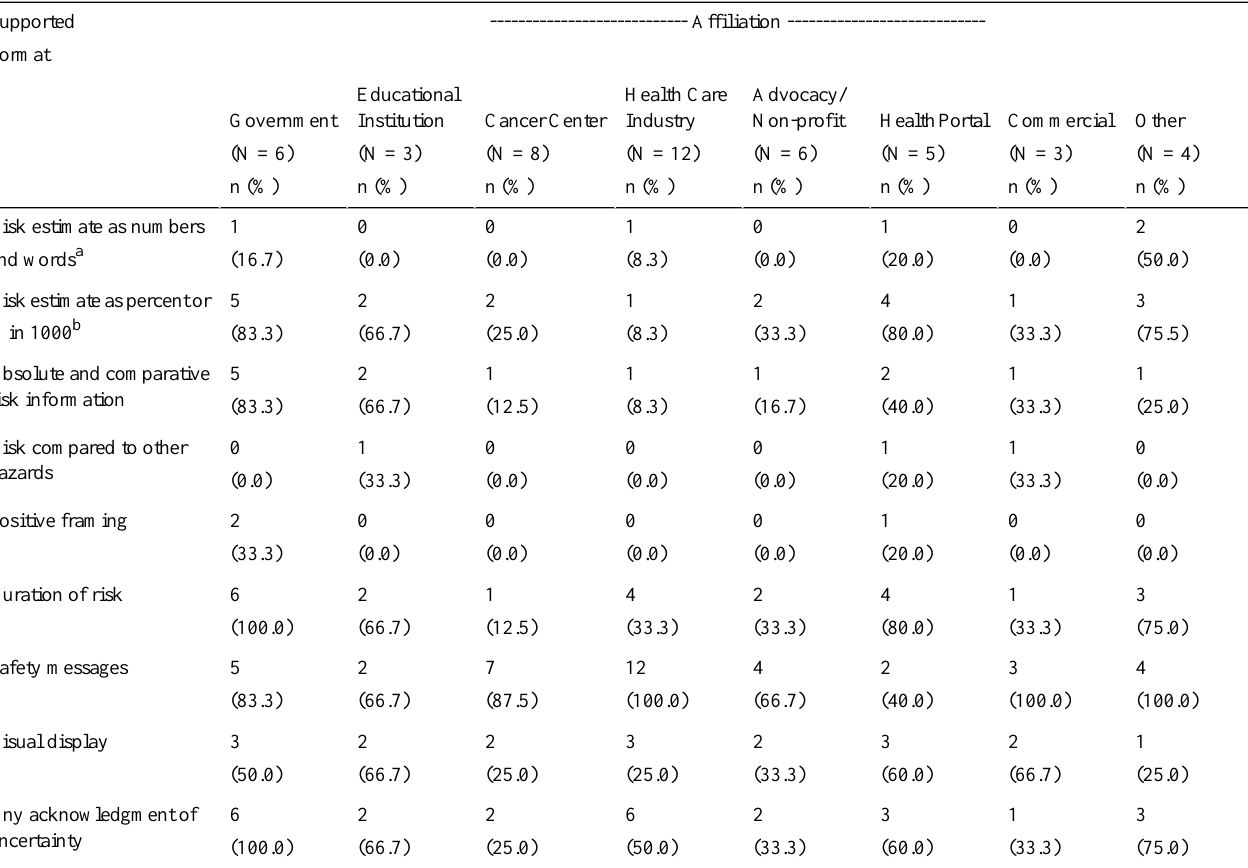
Table 6. Website affiliation-based variations in the use of risk communication formats that facilitate comprehension and reduce bias (N =